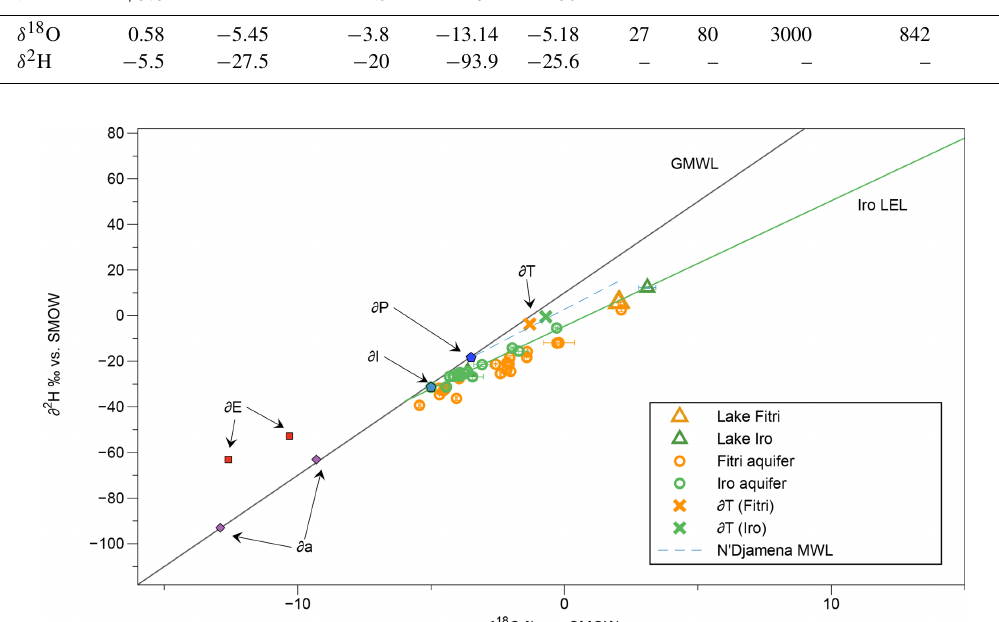
Figure 10. Representation of δT values. Green and orange circles represent, respectively, groundwater of Iro Lake and of Lake Fitri, while triangles indicate lake water. δI is the water entering the system for Iro Lake surface water and groundwater and for Lake Fitri surface water only. δP is the weighted annual rainfall at N’Djamena and δT is the transpiration isotopic composition calculated according to Jasechko et al. (2013). δa represents the minimum and the maximum values of atmospheric isotopic composition and δE indicates the minimum and the maximum values of evaporated isotopic composition, calculated according to the Craig–Gordon